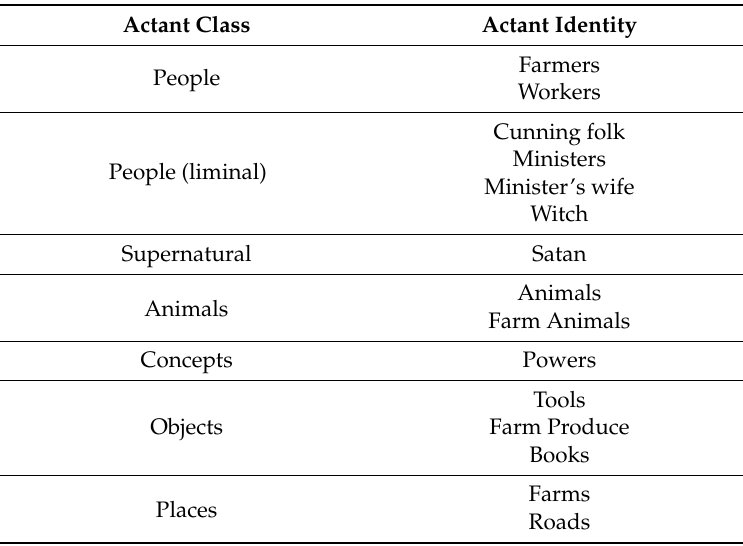
Table 2. Actants in the Cunning Folk–Witch